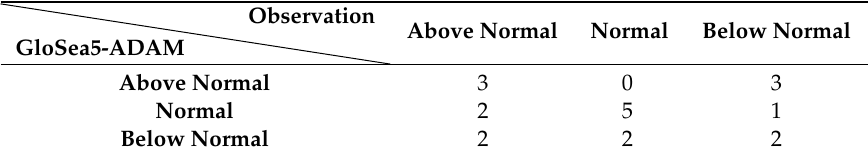
Table 1. Contingency table for verification of springtime seasonal Asian dust hindcast (1991–2010) over South Korea. Observation Above Normal Normal Below Normal GloSea5-ADAM Above Normal 3 0 3 Normal 2 5 1 Below Normal 2 2